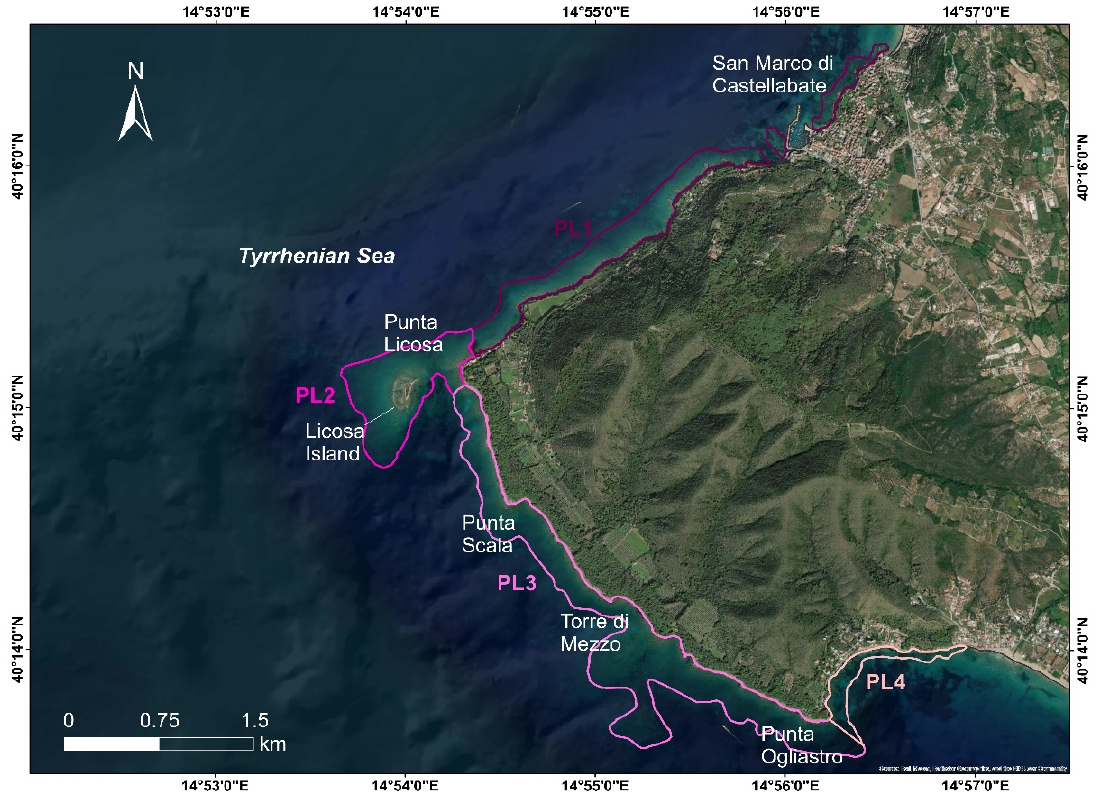
Figure 7. Division of the Punta Licosa Promontory into four coastal sectors (PL1 to PL 4) based on their exposure to the wave action.